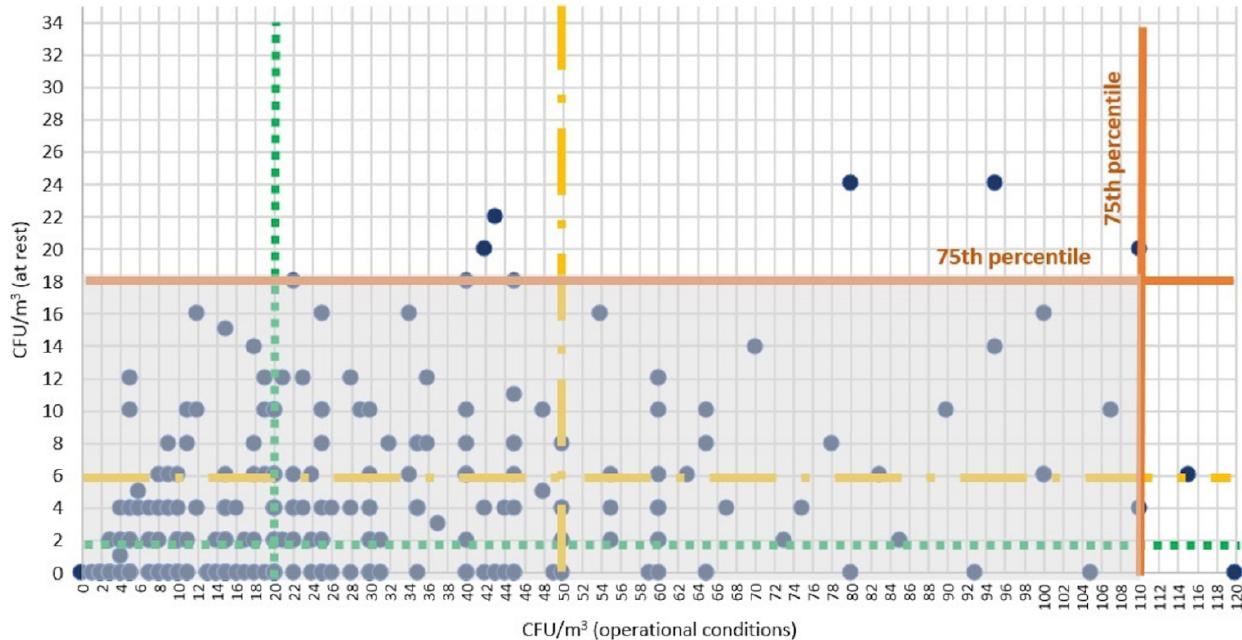
Figure 2. Microbial load values per operating theatre in operational and at rest conditions during the first five years of observation in relation to the Italian guidelines’ reference values (continuous vertical and horizontal line, respectively).